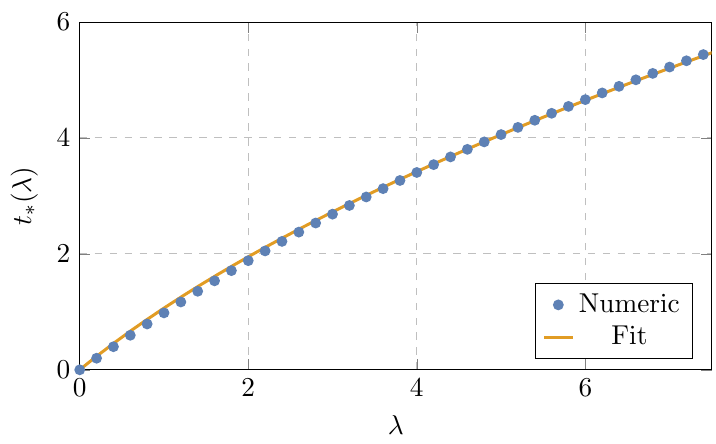
Figure 6. We plot the numerically determined t ∗ ( λ ) (blue marks) against a simple fit √ p p 4 2 /π ( λ + π − π 1 / 4 ) (solid yellow). This matches the expected large λ asymptotics from the instanton expansion, (3.12). This simple fit overestimates the slope at small λ by about 20% , for which t ∗ ∼ λ , as expected from degenerate perturbation